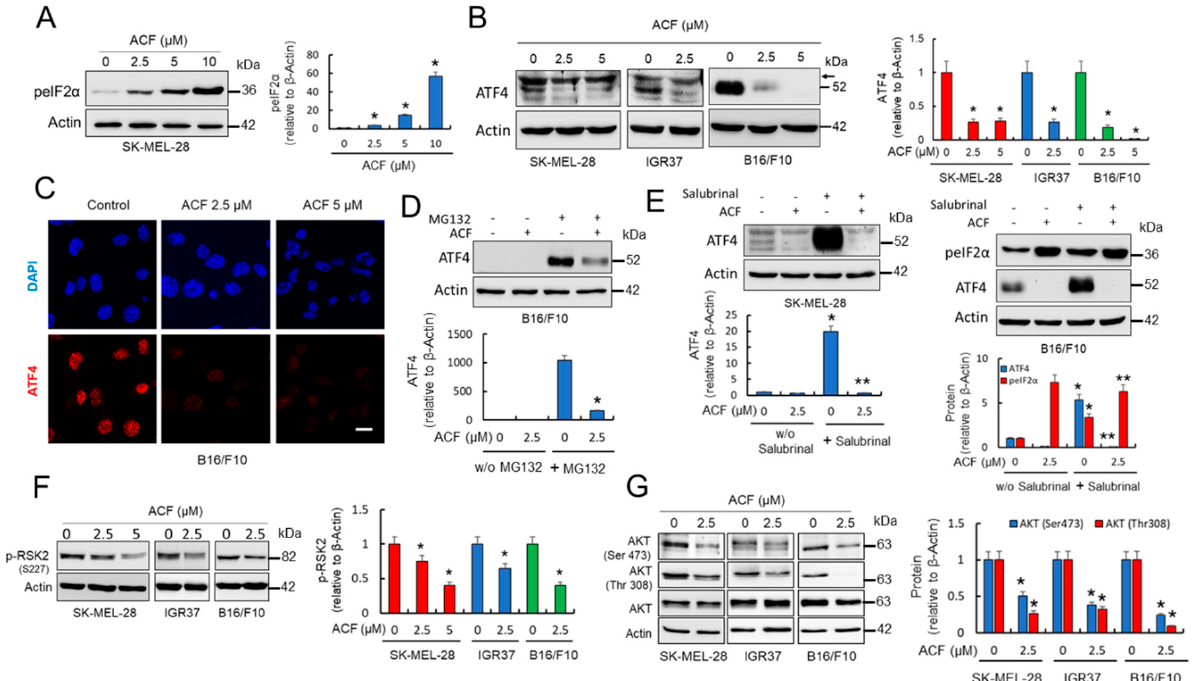
Figure 4. ACF compromises ATF4 protein stability in melanoma cells. ( A ) Effect of ACF (24 h) on p-eIF2 α expression in SK-MEL-28 melanoma cells analyzed by western blot. IOD quantification is shown (histogram; * p < 0.05 when compared with untreated control). ( B ) Western blot analysis of ATF4 in melanoma cells under indicated conditions (cells were treated with ACF for 24 h). Histogram represents ATF4 protein levels (detected as a band at 52 kDa) estimated by IOD in western blots after normalization to the β -actin IOD. The values represent the mean from two experiments performed in triplicate. * p < 0.05 when compared with ACF-untreated control experiments. Arrow indicates a nonspecific band observed in human samples at 58 kDa. ( C ) Confocal microscopy analysis (63X magnification) of ATF4 in control B16/F10 cells and those subjected to indicated ACF (24 h) treatments (bars, 27 µ M). ( D ) Western blot experiments for the effect of ACF (2.5 µ M) on ATF4 expression in the absence or the presence of MG132 (10 µ M). SK-MEL-28 cells were treated for 12 h with ACF alone or simultaneously co-treated with ACF and MG132. MG132 significantly increased ATF4 in ACF-treated cells (* p < 0.05). ( E ) Western blot experiments for the effect of ACF (2.5 µ M) on ATF4 expression in the absence or the presence of salubrinal (20 µ M). Melanoma cells were treated during 24 h with ACF alone or simultaneously co-treated with ACF and salubrinal. As observed, ACF impedes ATF4 stabilization under forced stabilization of p-eIF2 α * p < 0.05 and ** not significant when compared salubrinal treatments with their respective treatments without salubrinal (w/o salubrinal). ( F ) Effect of ACF (24 h) on the phosphorylation of RSK2 (p-RSK2) in melanoma cells analyzed by western blot. p-RSK2 (histogram) was estimated by integrated optical density (IOD) in western blots after normalization to the β -actin IOD. The values represent the mean from two experiments performed in triplicate. * p < 0.05 when compared with the ACF-untreated control experiments. ( G ) AKT phosphorylation was examined in melanoma cell extracts and compared with the expression levels of total AKT and β -actin. IOD quantification is shown (histogram; * p < 0.05 when compared with their respective untreated